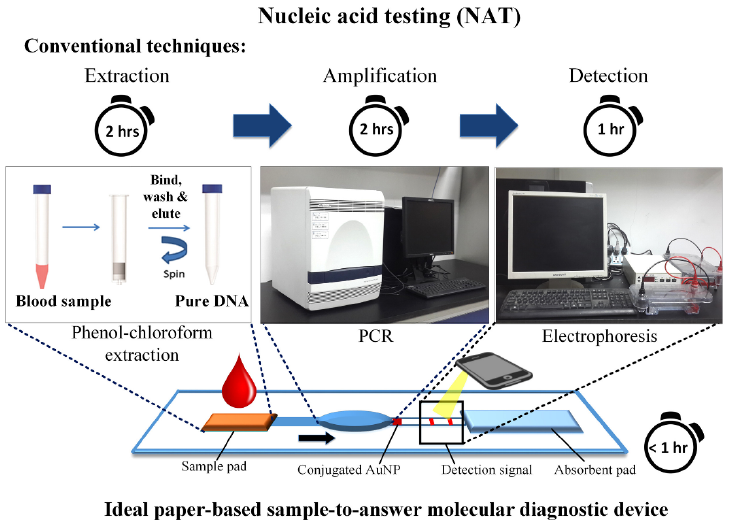
Figure 2. Paper-based molecular diagnostic device. Reprinted with permission from Elsevier B.V. [10], Copyright (2015).